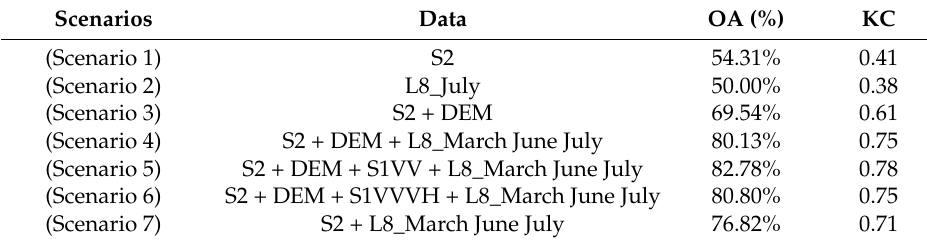
Table 9. Results of seven tested scenarios for classifying forest types based on RF